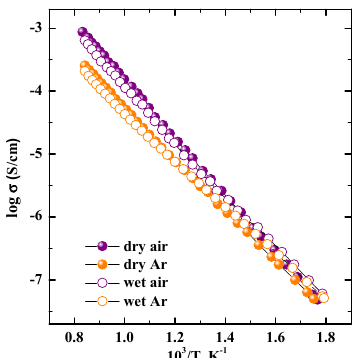
Figure 5. Temperature dependencies of conductivity for SrLa 2 Sc 2 O 7 composition obtained under dry (filled symbols) and wet (open symbols) conditions.